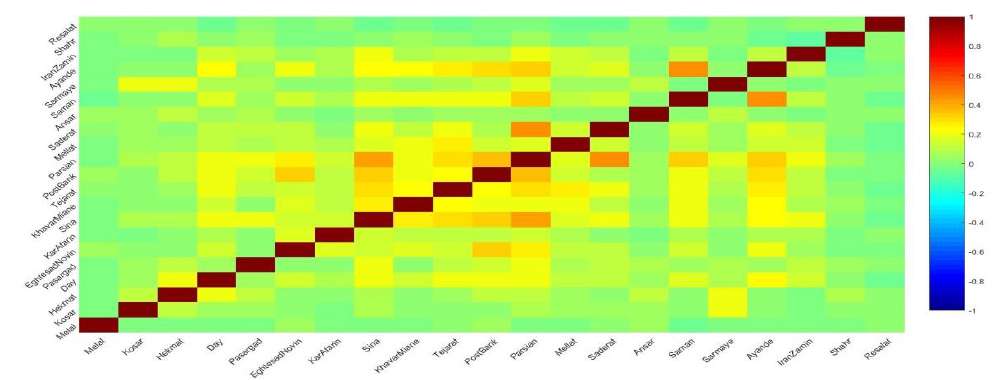
Figure 10. Heat maps of banks clustered by ward method and shows that Ayande and Saman bank has the strongest correlation which is also approved in the